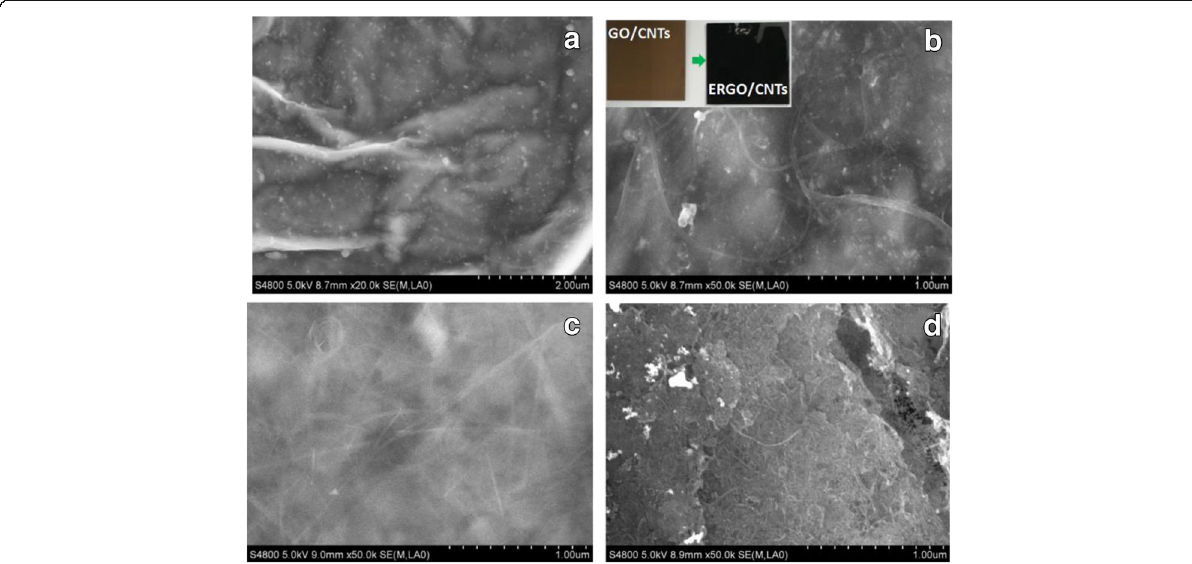
Fig. 1 SEM images of ERGO ( a ) and ERGO/CNTs obtained from GO/CNTs with different mass ratios: b GO/CNTs = 100:1, c GO/CNTs = 50:1, and d GO/CNTs = 10:1; the inset images in ( b ) are photo pictures of GO/CNTs before and after electrochemical